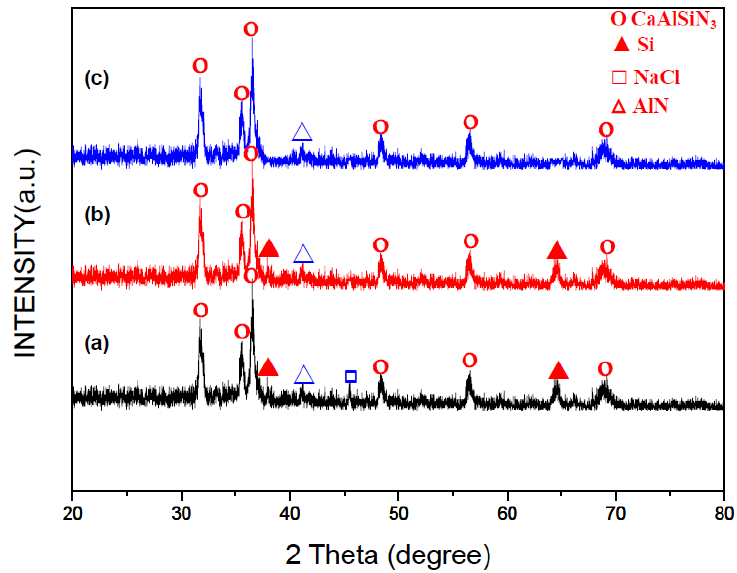
Figure 3. XRD patterns of the products: ( a ) as-synthesized; ( b ) after washing with water; and ( c ) after washing with water and an